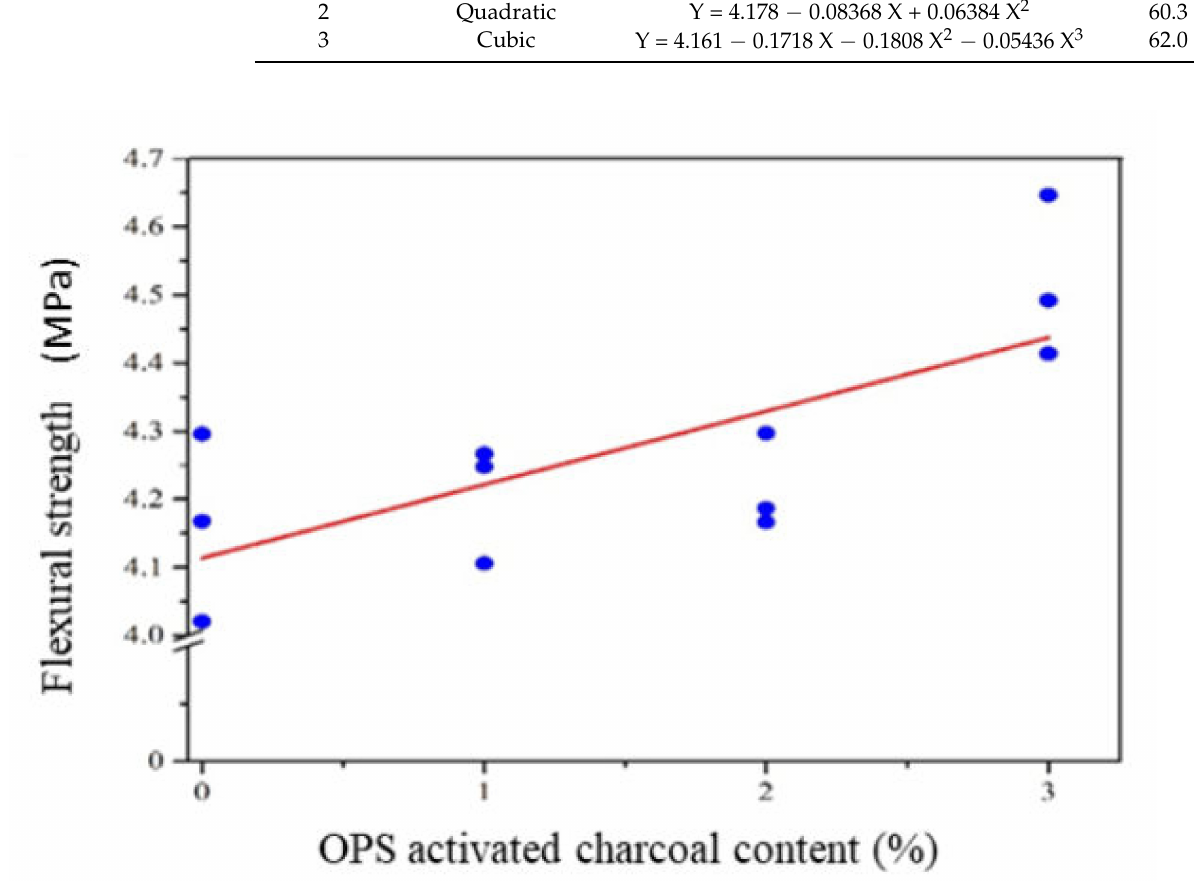
Figure 7. The flexural strength of the mortar with OPS-activated carbon